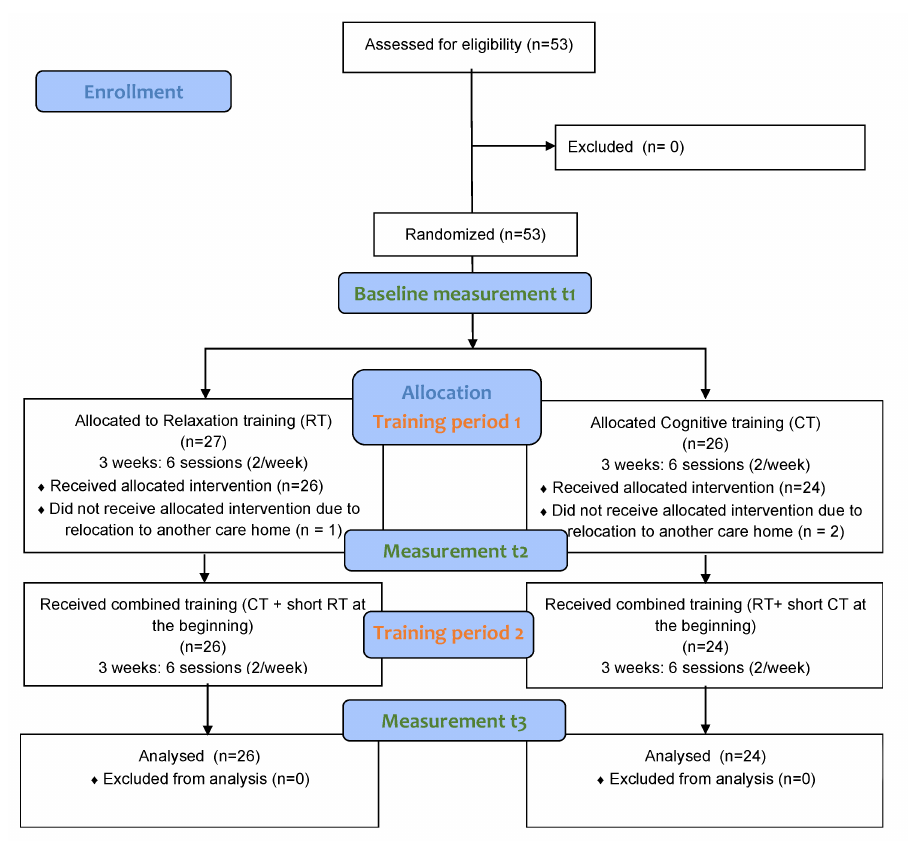
Figure 1. Participant